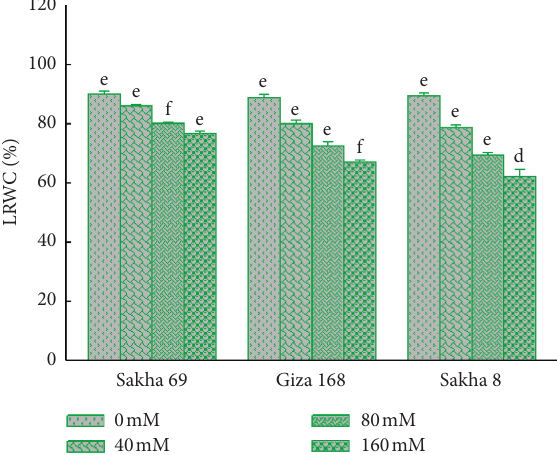
Figure 1: NaCl stress (0, 40, 80, and 160mM) reduced the leaf relative water content (LRWC) of wheat cultivars. Each column symbolizes mean ± SE ( n � 3). Means and standard errors are demonstrated by error bars. Letters point out significant differences at p < 0 . 05.